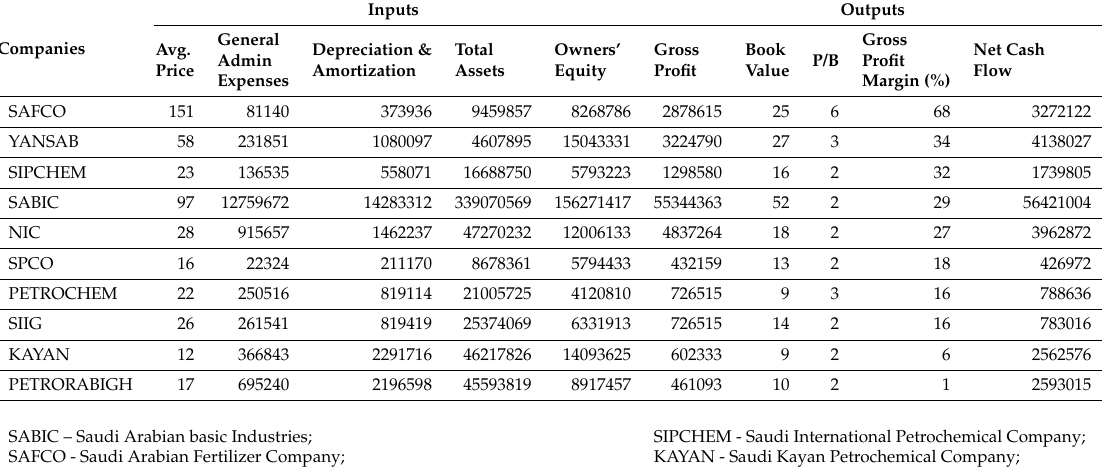
Table 1. Petrochemicals Input and Output Data for 2013, as on 31/12/2013